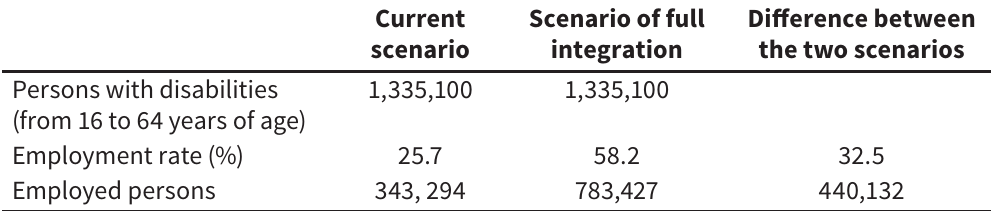
Current situation of people with disabilities in the labor market and basic figures referring to the Scenario with no exclusion, 2014 Current Scenario of full Difference between scenario integration the two